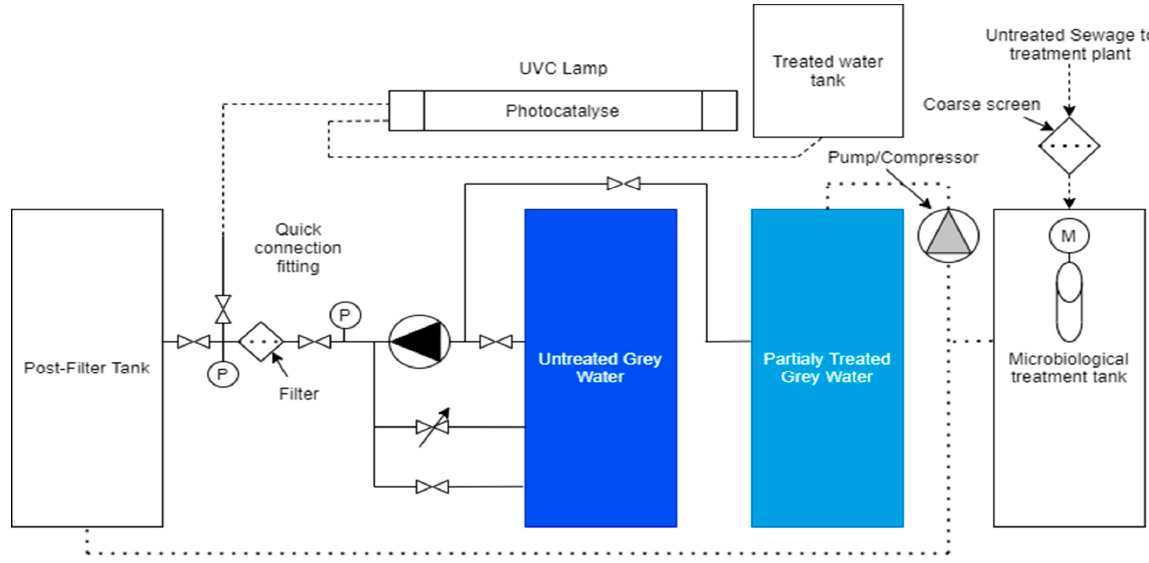
Figure 10. Grey water treatment